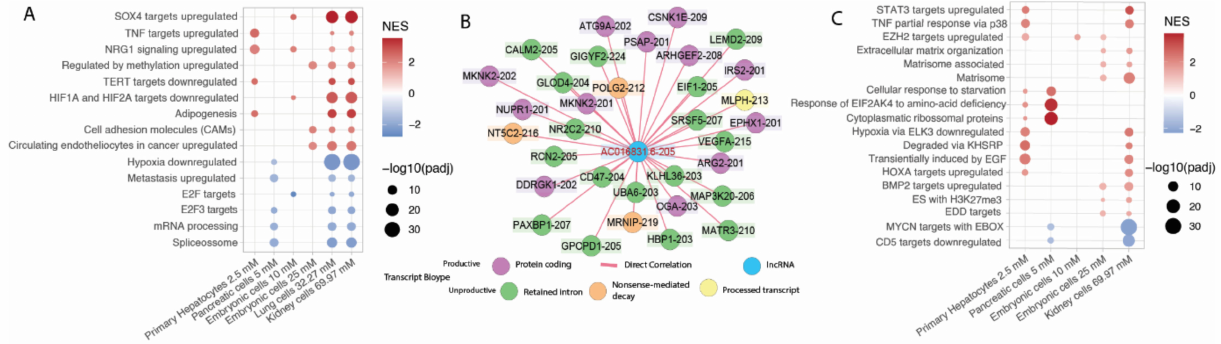
Figure 5. ( A ) enrichment of AC016831.6-205 (ENST00000604514.1) targets using fgsea algorithm and the MsigDB C2 pathway dataset. NES was calculated using correlation values as the ranking; thus, positive NES indicates direct correlation between those target-transcripts and the pathway, and negative NES indicates inverse correlation between those target-transcripts and the pathway. Only protein-coding transcripts were used as target genes for this analysis. The use cutoff was p -adjusted inferior to 0.0001. x axis ordered according to series metformin concentration. ( B ) Network representation of target genes of AC016831.6-205 (ENST00000604514.1) are differentially expressed transcripts in at least 4 series and pass on the correlation cutoff (corr > 0.8 and p -value < 0.01). ( C ) enrichment of NEAT1-202 targets using fgsea algorithm and MsigDB C2 pathway dataset. Other information same as